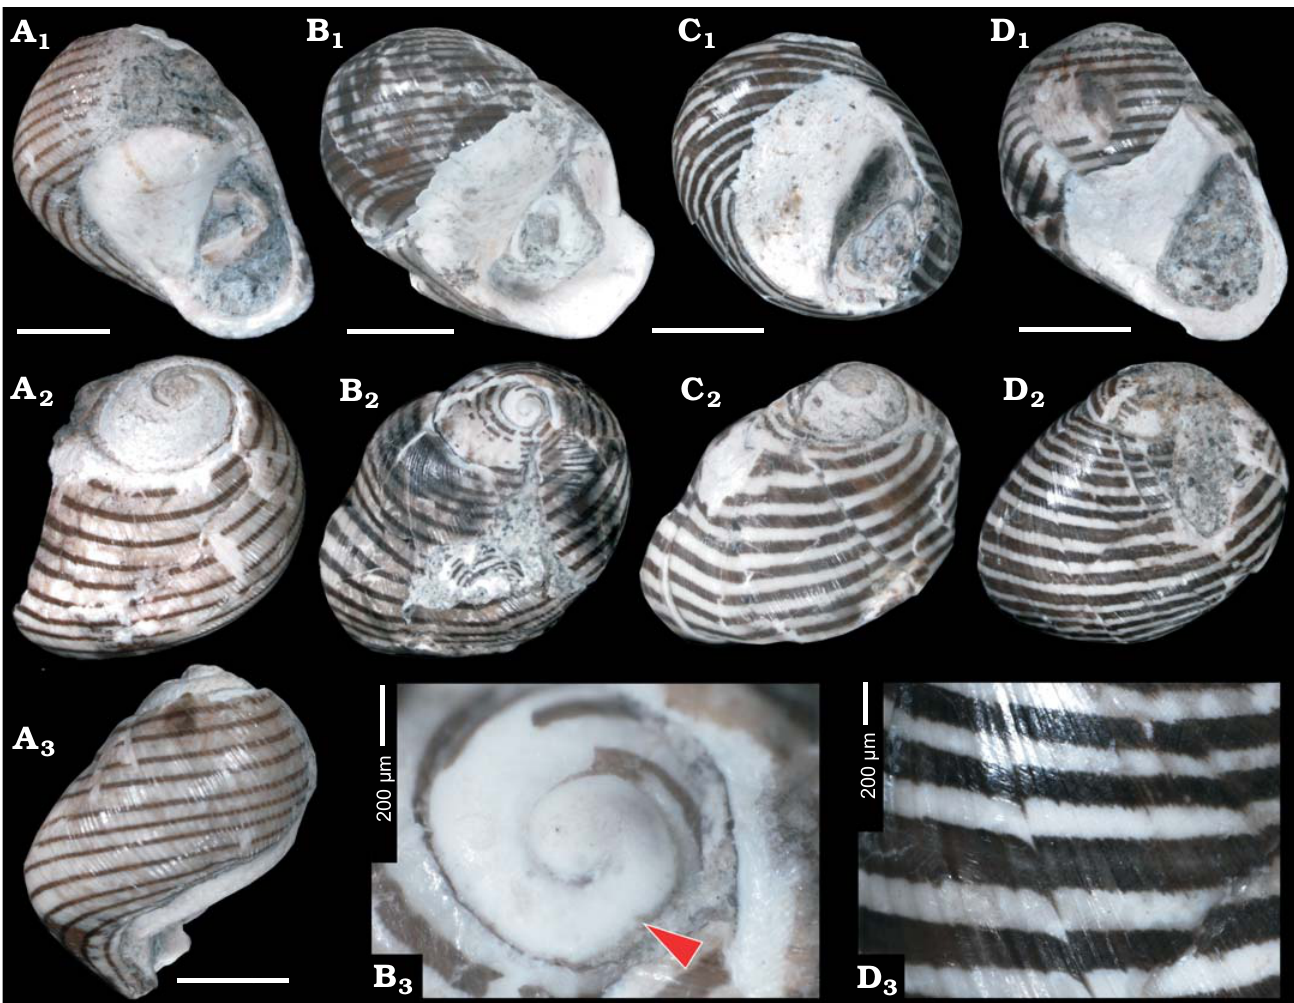
Fig. 2. Neritid gastropod Theodoxus susuzianus sp. nov. from the upper Oligocene–lower Miocene Susuz Formation, Kömürlü, Turkey. A . NHMW 2018/0019/0001, holotype in apertural (A 1 ), oblique apical (A 2 ), and dorsal (A 3 ) views. B . NHMW 2018/0019/0002, paratype in apertural (B 1 ) and oblique apical (B 2 ) views; detail of protoconch (B 3 ), arrowhead indicates transition into teleoconch. C . NHMW 2018/0019/0003, paratype in apertural (C 1 ) and oblique apical (C 2 ) views. D . NHMW 2018/0019/0004, paratype in apertural (D 1 ) and oblique apical (D 2 ) views; details of sculpture (D 3 ). Scale bars 2 mm, if not stated